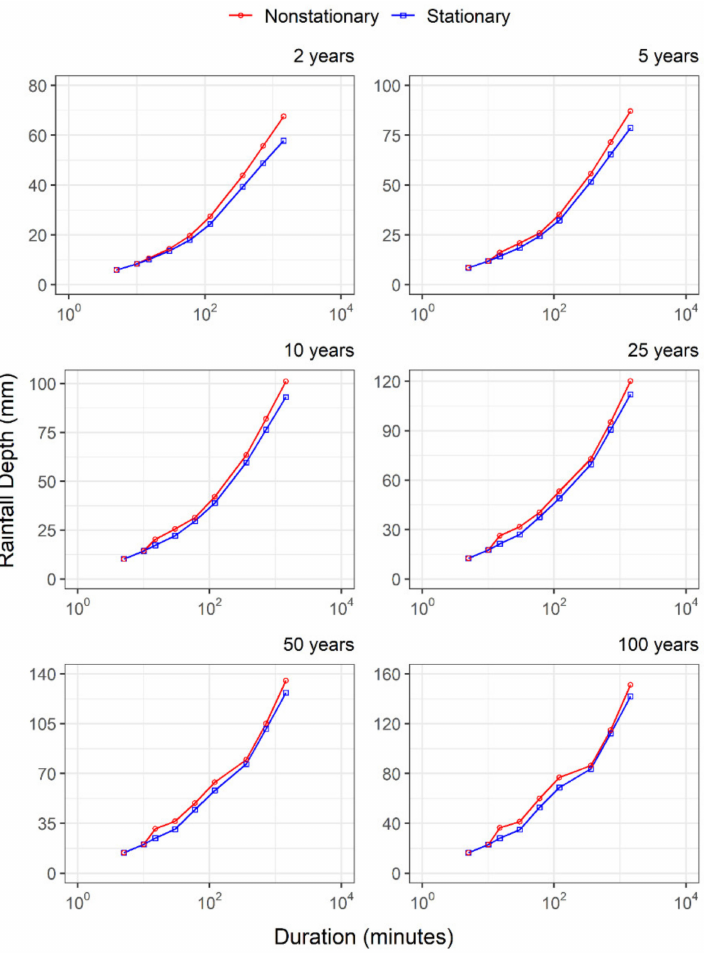
Figure 3. Stationary and non-stationary rainfall depths for different return periods for Moncton